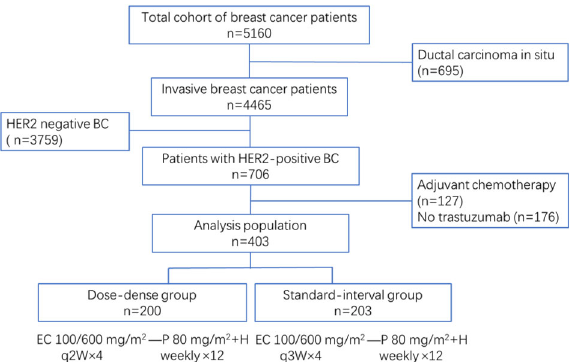
Fig. 1 Flowchart of patient selection in this study. On the basis of the eligibility criteria, a total of 403 patients meet the criteria for inclusion and are divided into the dose-dense group and the standard-interval group. BC breast cancer, HER2 human epidermal